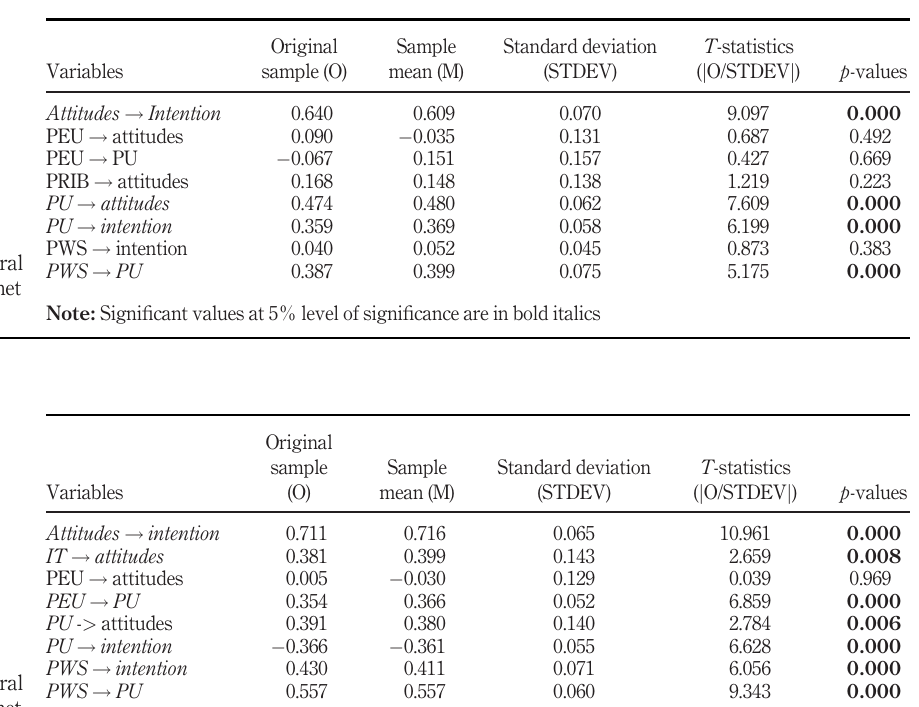
equation for internet banking non-users